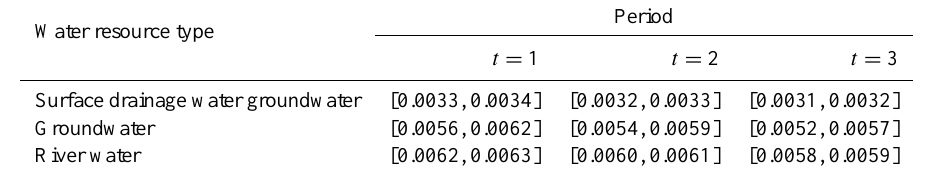
Table 2. Costs for pumping and delivering water resources (USDm − 3